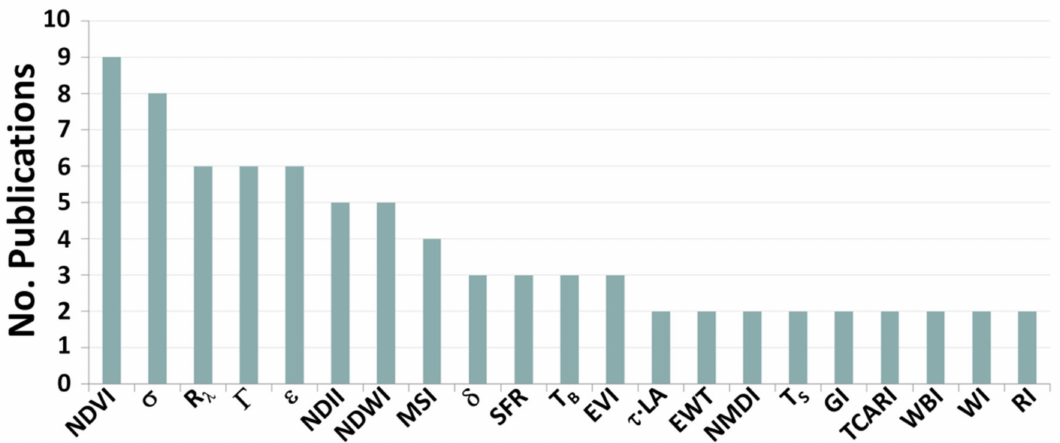
Figure 11. Number of publications in which each water estimator is used, considering only the estimators that have been used two or more times. Note that each publication can use more than one water indicator. NDVI = Normalized difference vegetation index, σ = Backscattering coefficients, R λ = Spectral reflectance, Г = Reflection coefficient, ε = Dielectric constant, NDII = Normalized difference infrared index, NDWI = Normalized difference water index, MSI = Moisture stress index, δ = Absorption coefficient, SFR = Sap-flow rate, T τ = Leaf B = Brightness temperature, EVI = Enhanced vegetation index, optical depth, LA = Leaf surface area, EWT = Equivalent water thickness, NMDI = Normalized multi-band drought index, T S = Land surface temperature, GI = Greenness index, TCARI = Transformed chlorophyll absorption in reflectance index, WBI = Water band index, WI = Water index, RI = Refractive